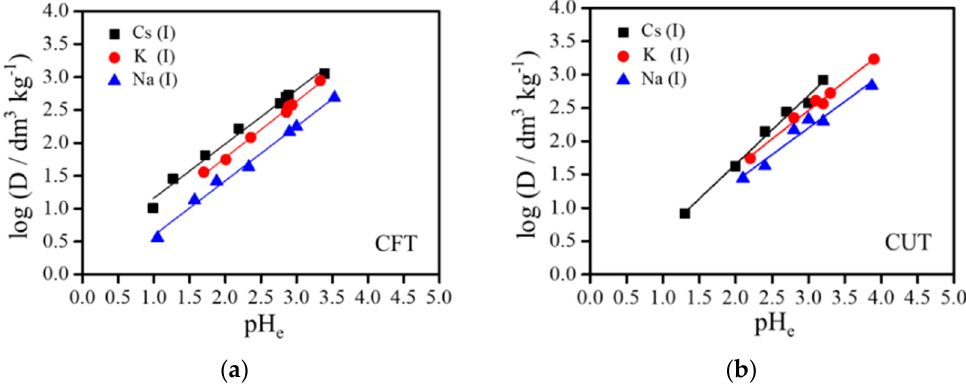
(CFT) adsorbents and ( b ) crosslinked used tea leaves (CUT) adsorbents at 303K, adsorbent weight = 0.05 g, solution volume = 10.0 cm 3 , [M + ] i = 1.0 mM each, shaking time = 24 h.